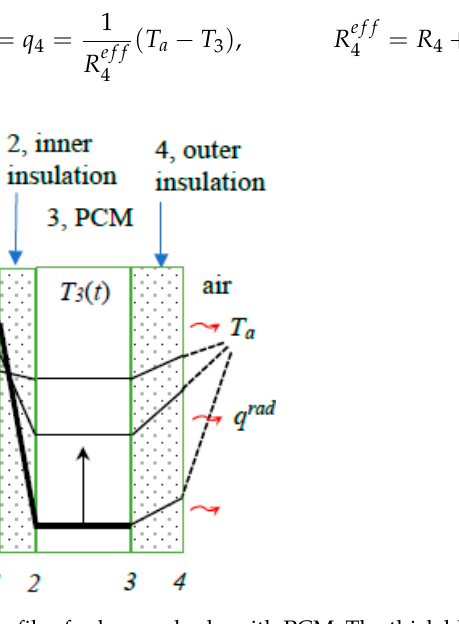
Figure 3. Temperature profiles for human body with PCM. The thick black line indicates the initial temperature profile.